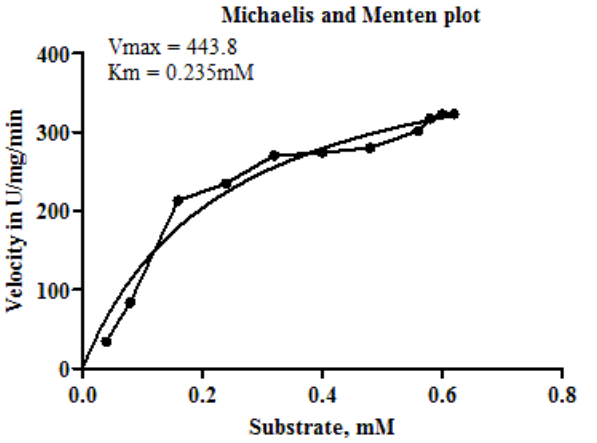
Figure 11. Effect of substrate concentration on L-glutaminase activity produced by A. xylosoxidans RSHG1 at 40 °C, pH 7.